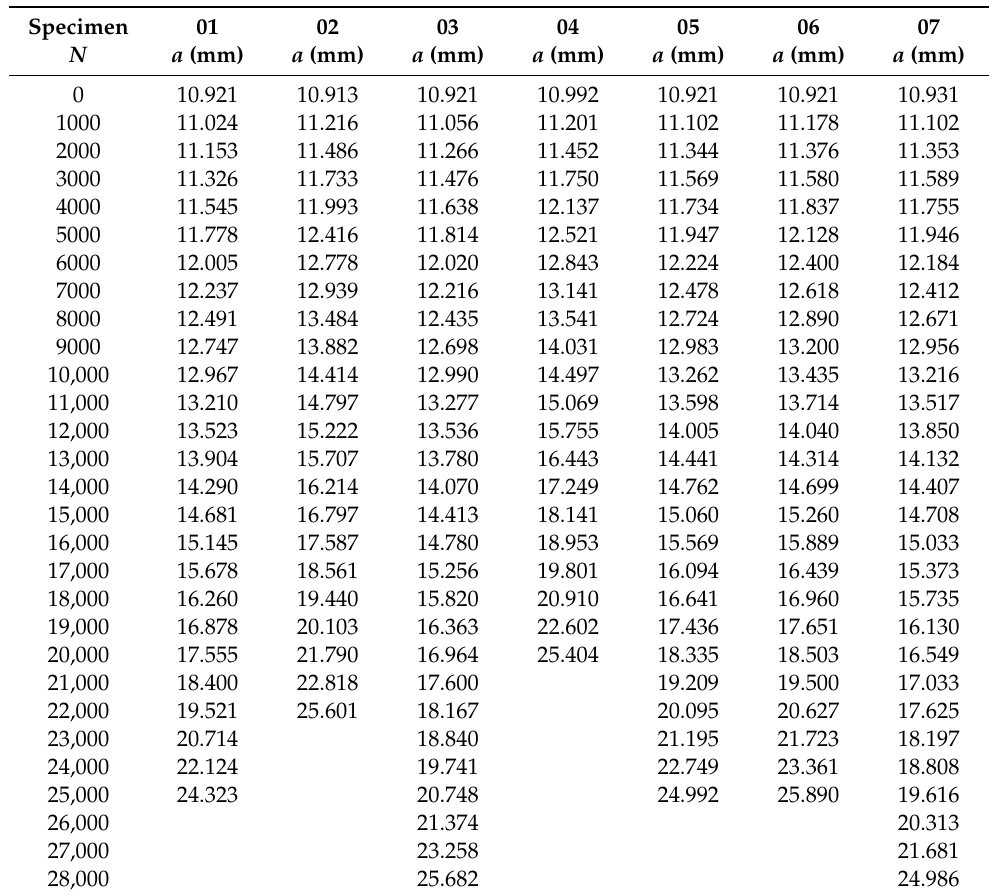
Table 2. Test data of crack growth